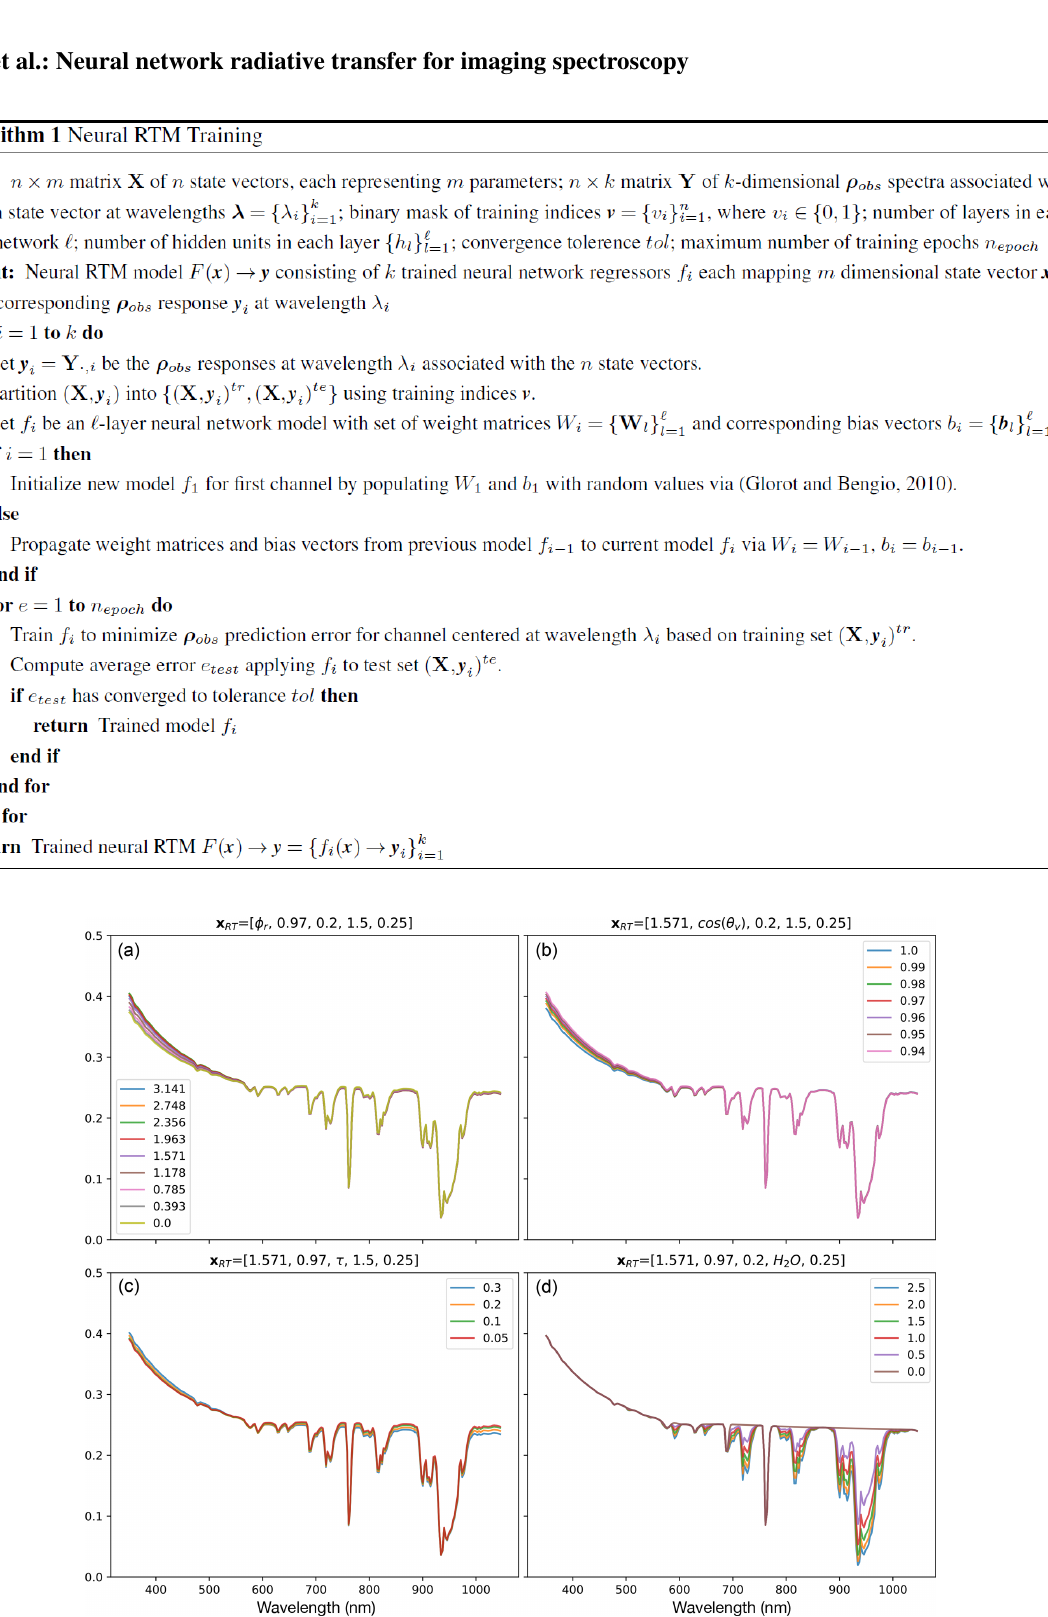
Figure 2. ρ obs spectra for ρ s = 0 . 25 spanning the range of the φ r (a) , cos (θ v ) (b) , τ (c) , and H 2 O (d) parameters with respect to the validation grid